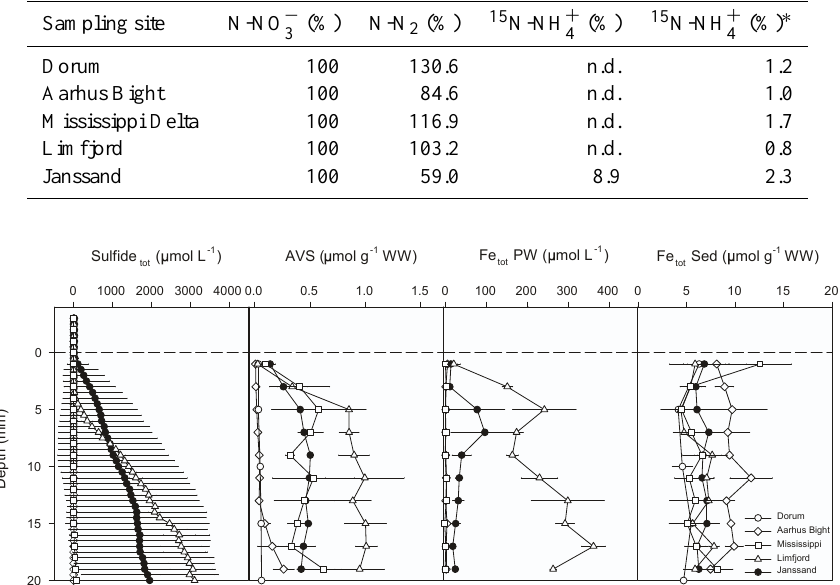
Fig. 3. Pore water sulfide (Sulfide tot ) , AVS (acid-volatile sulfide), Pore water iron (Fe tot PW) and Solid-phase iron (Fe tot Sed) of the different sampling sites. Solid-phase pools (AVS and solid-phase iron) are shown per gram wet weight (WW). Means ± standard deviation of 3 replicate sub cores are shown.